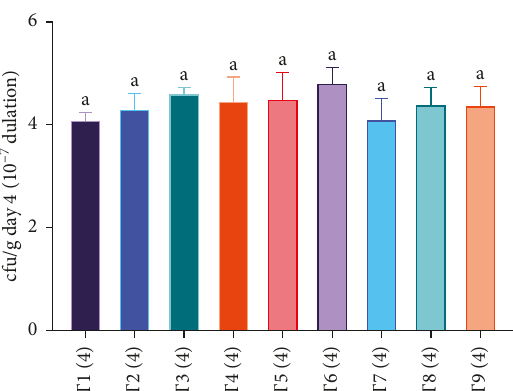
Figure 4: Comparison of bacterial survival of quinoa cake treatments after 4 days from baking through pour plate in NYSM agar medium. The cfu/g in quinoa cake treatments on day four were not different significantly from each other at p expressed as mean SD from at least three separate experiments. Inter-group comparisons were made using one way ±